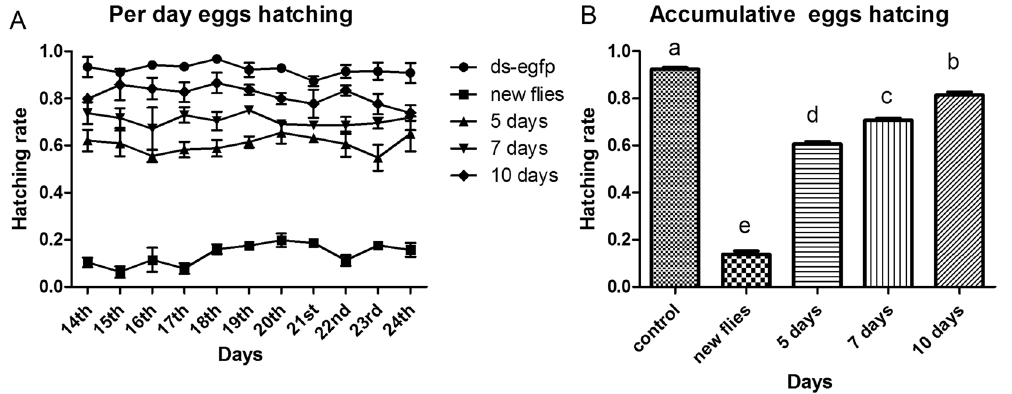
Figure 7. Egg hatching rate in response to 1000 ng/ μ l of dsRNA ( boul + zpg ) genes in different ages of adult males. ( A ) The average number of eggs hatched per day between target gene dsRNA and ds-EGFP at different concentrations were noted. ( B ) One way ANOVA indicates a difference in the accumulative number of eggs hatched after feeding 1000 ng/ μ l dsRNA to males of different ages at compared with the control group (ds- EGFP). Different letters indicated the significant differences between all treatments. Three biological replicates were performed (P < 0.0001, Tukey